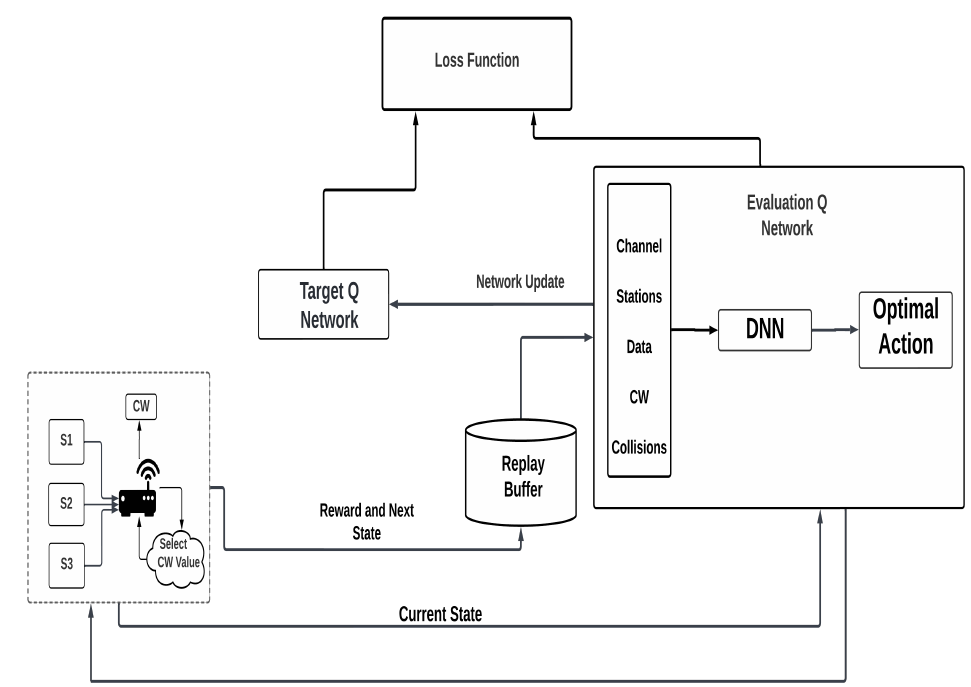
Figure 4. DDQN Approach for